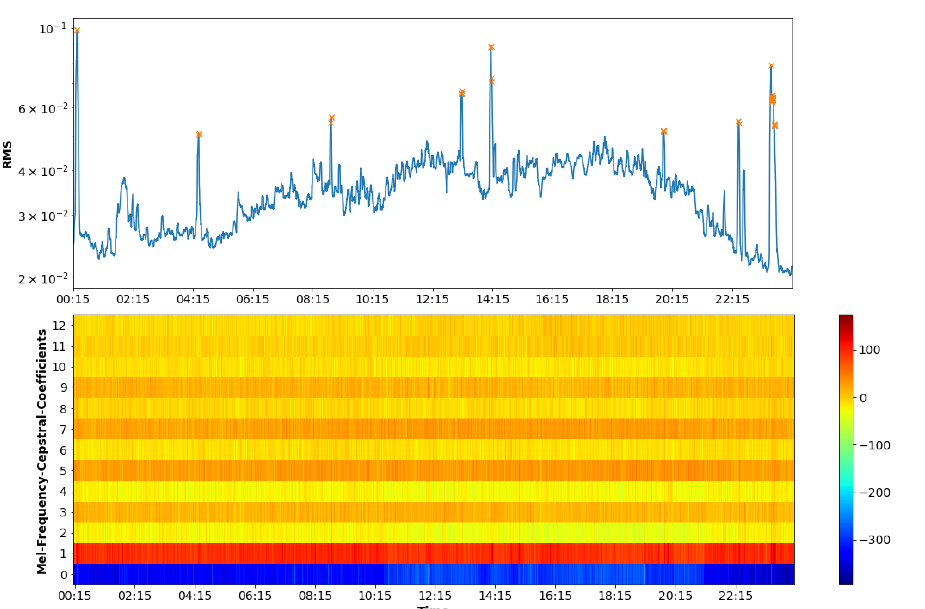
Figure 5. RMS curve and corresponding MFCCs for a hive with with 3 full boxes of bees (12 August